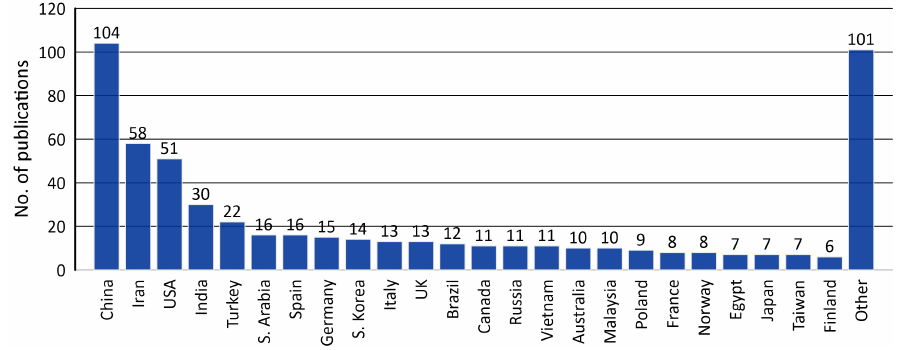
Figure 2. Publications from different countries or regions (Scopus, 2020-23).